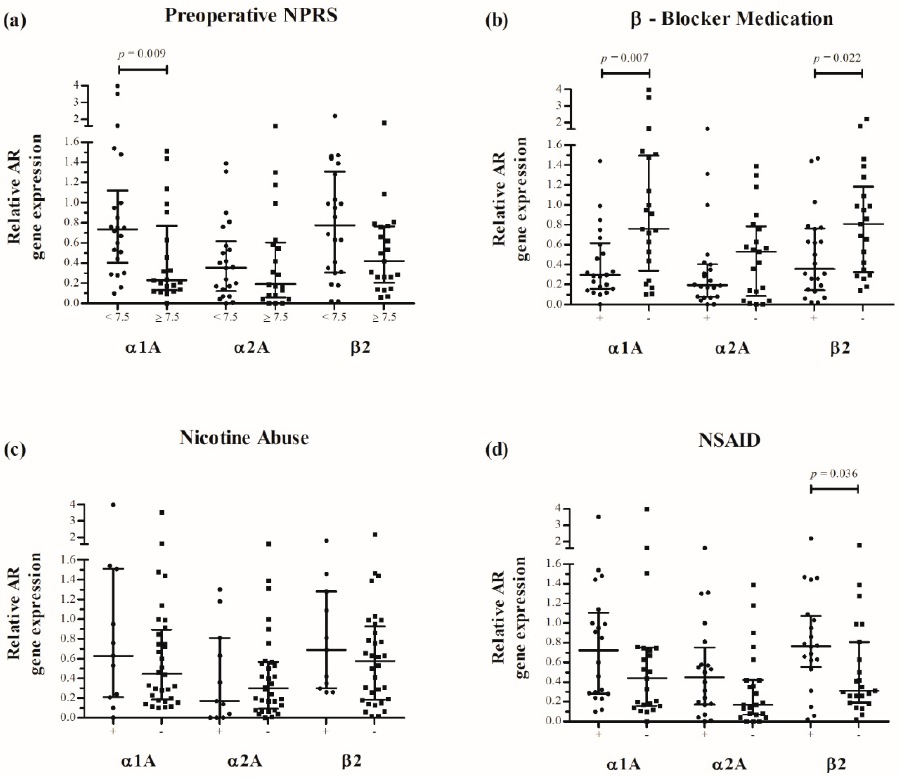
Figure 3. Correlation between relative AR gene expression in IVD tissue and preoperative